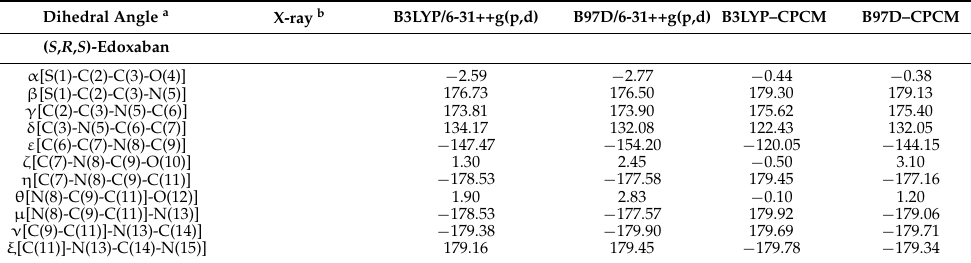
Figure 1. Structure and atom labeling in the anticoagulant drugs studied. Table 1. Optimized dihedral angles (degrees) of the drugs studied.